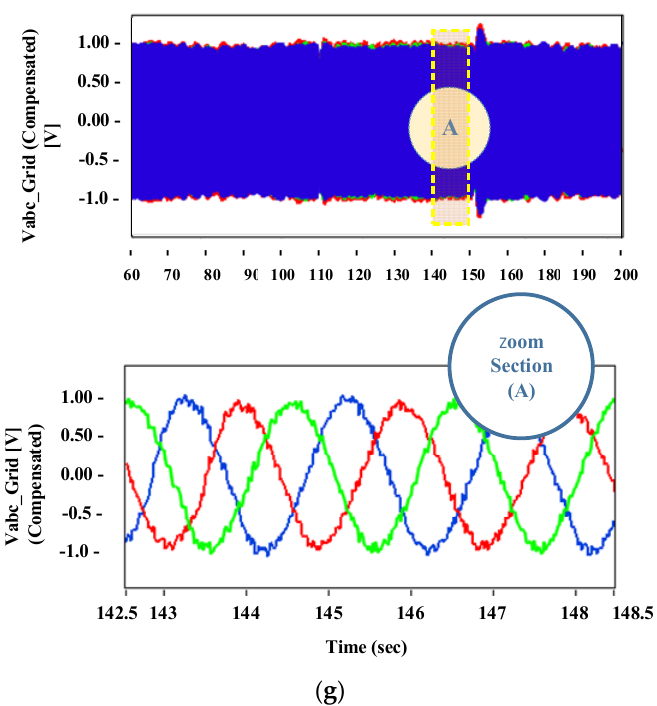
Figure 12. Hardware results of the proposed technique: ( a ) asymmetric grid voltage, ( b ) regulated DC-link voltage, ( c ) positive sequence voltages, ( d ) positive sequence currents, ( e ) negative sequence currents, ( f ) active and reactive powers during fault compensation, and ( g ) compensated three-phase grid voltages.